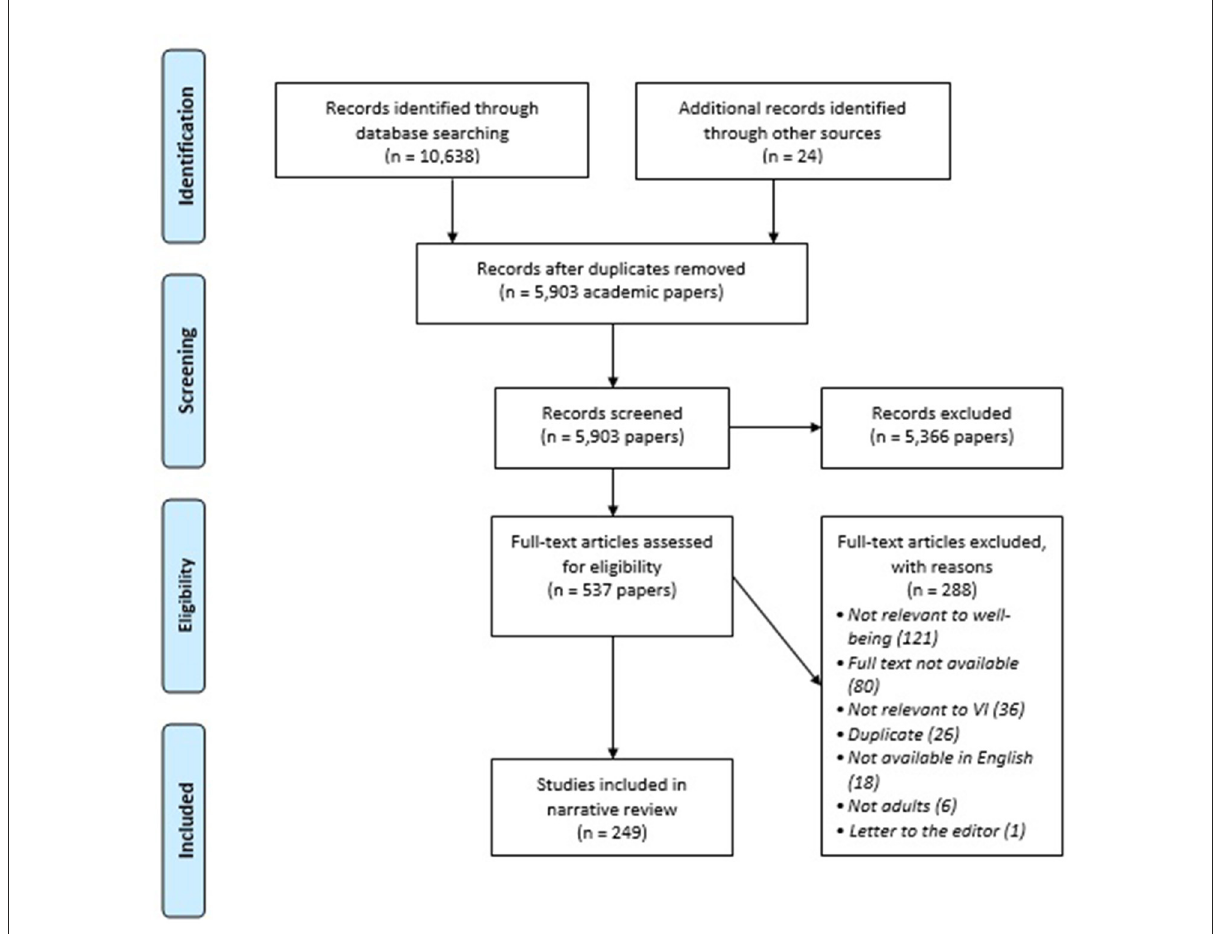
FIGURE1 PRISMA 2009 flow